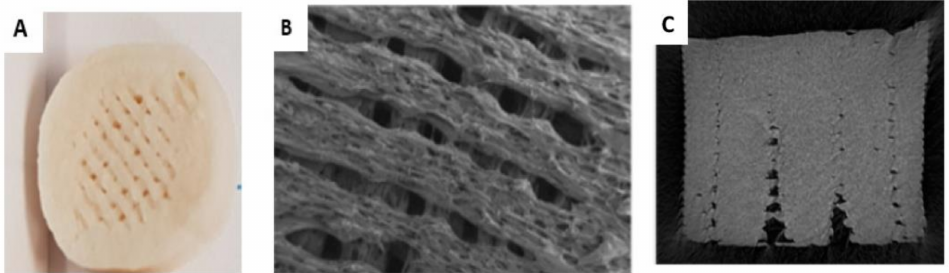
Figure 4. A collection of captures of 100% infill printed tablets showing the gaps within their layers: ( A ) phone picture of the surface (lab work), ( B ) SEM image for the top surface [6], ( C ) X-ray micro-CT image of cross-section [33].